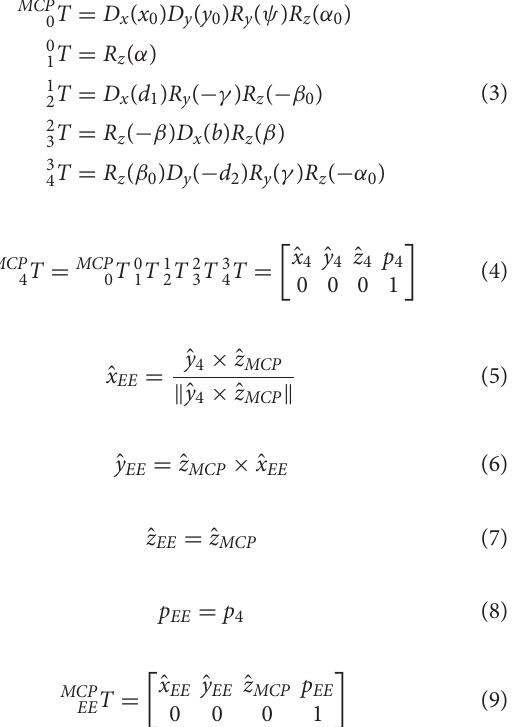
The end-effector position coordinates x EE , y EE and z EE are obtained from p EE ( Figure 7 ). The end-effector angle ϕ EE , corresponds to the angle between ˆ x EE and ˆ x MCP and is computed by Equation (11). For the upcoming synthesis of the mechanical design parameters, this angle was bounded to ϕ EE ∈ [ − 90 ◦ , 270 ◦